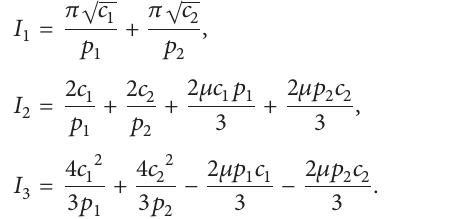
Table 10. A graph of the two solitary waves collision,